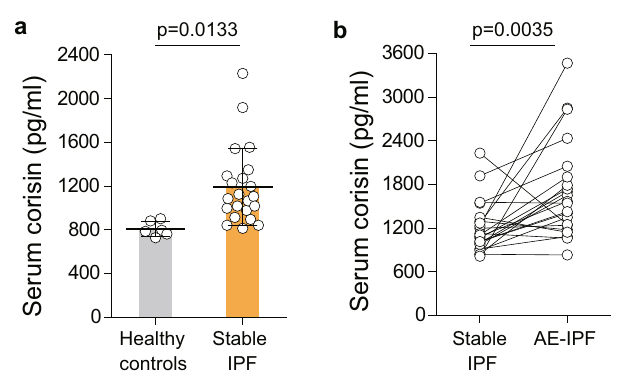
Fig. 9 Signi fi cant increase in serum corisin level in idiopathic pulmonary fi brosis patients with acute exacerbation. a , b Corisin was measured using an enzyme immune assay using rabbit polyclonal antitransglycosylase antibody as coating antibody and rat monoclonal anticorisin antibody as secondary antibody. Healthy controls, n = 6; all stable idiopathic pulmonary fi brosis (IPF) patients, n = 22; IPF patients with acute exacerbation, n = 22. Bars indicate the means ± S.D. Statistical difference between healthy controls and stable IPF patients was evaluated by two-sided unpaired t test, and statistical difference between stable IPF and acute exacerbation-IPF patients by two-tailed paired t test. The source data underlying ( a , b ) are provided in the Source Data fi